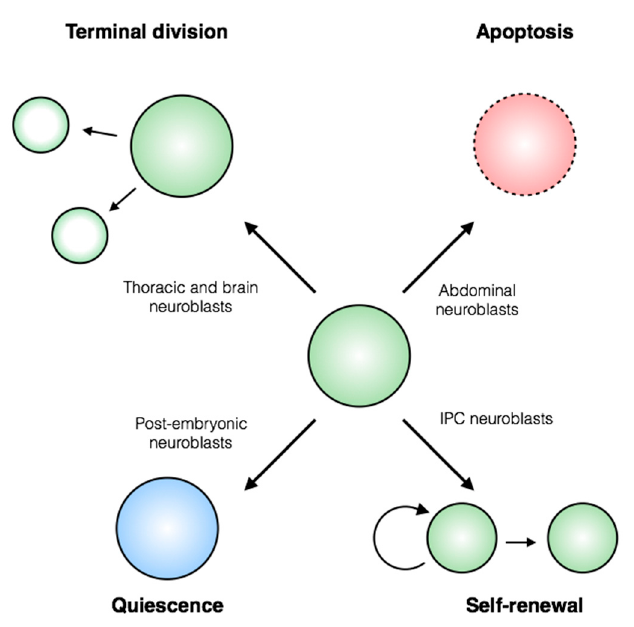
Figure 1. Stem cell-fate decisions in the Drosophila central nervous system. Drosophila neural stem cells, called neuroblasts, exhibit diverse stem cell behaviors. Thoracic and brain neuroblasts are eliminated by terminal division (top left), while abdominal neuroblasts undergo apoptosis (top right). Temporal controls regulate the period of neuroblast quiescence between embryonic and larval stages of development (bottom left). Certain larval neuroblasts within the inner proliferating center (IPC) of the optic lobe switch from renewing asymmetric to amplifying symmetric divisions (bottom right). Execution of these cell-fate decisions is intimately tied to neuroblast identity in time and space.